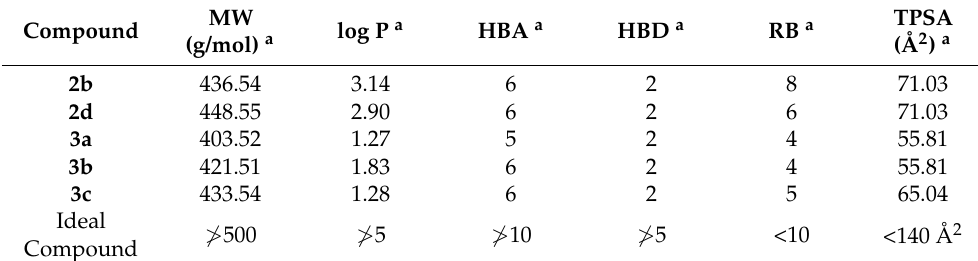
Table 6. Evaluation of 2b, 2d and 3a – c for some drug-like